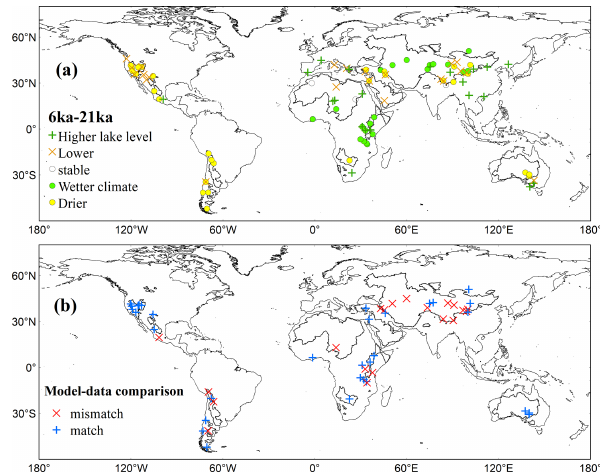
Figure 1. Wet–dry status changes between the LGM and MH from lake records (a) and comparison with the simulated effective precip- itation from PMIP3–CMIP5 multi-models (b) . The green and yel- low cross sites are from lake status databases; the green and yellow point sites are from recently published literature; the hollow points indicate that there is no significant change in lake level or climate condition between the LGM and